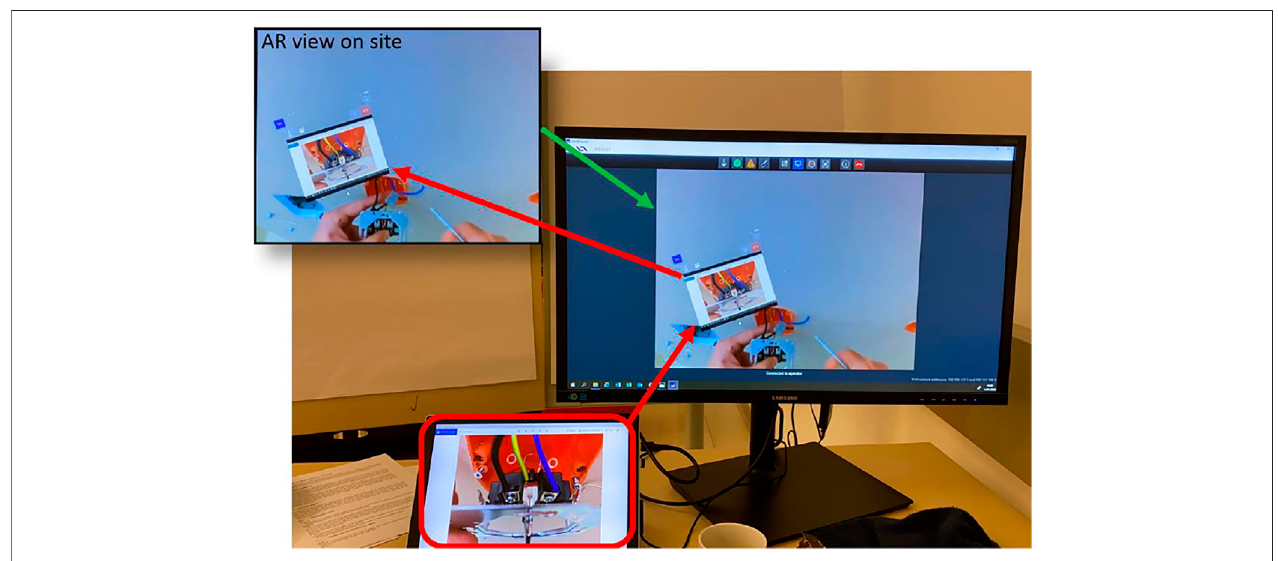
FIGURE 6 | Remote expert system: BIM and AR (Reprinted from Schranz et al., 2020).